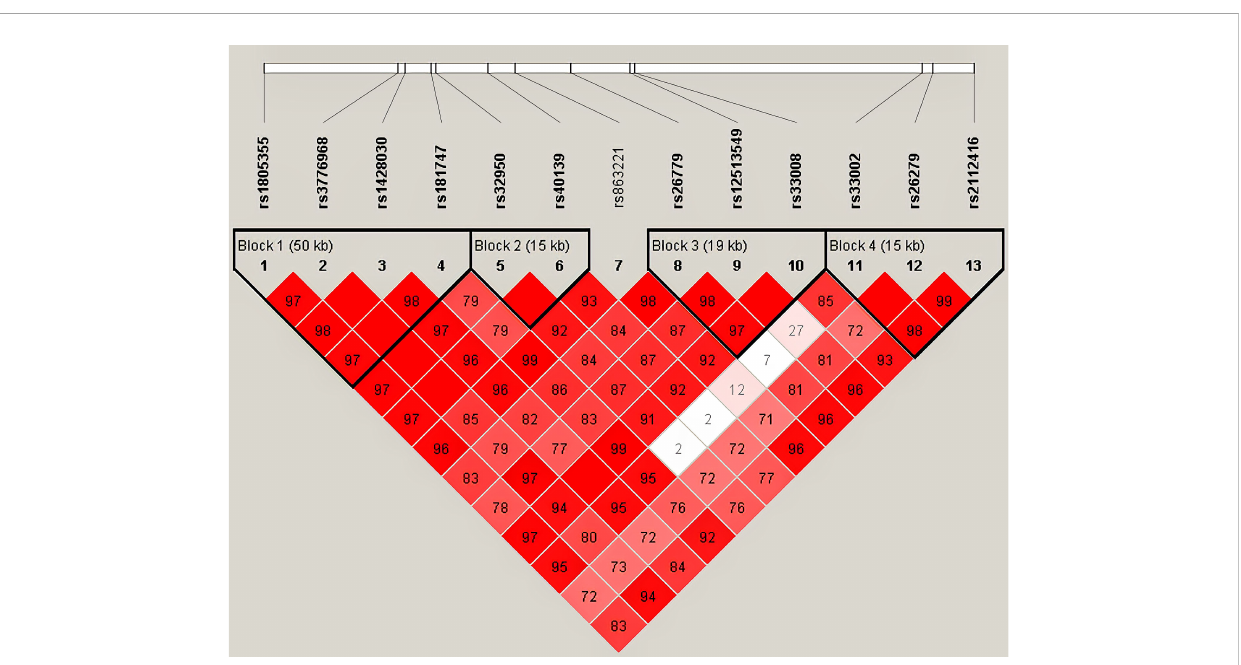
FIGURE 1 Haplotype analysis for 13 SNPs between HC and HCC by Haploview